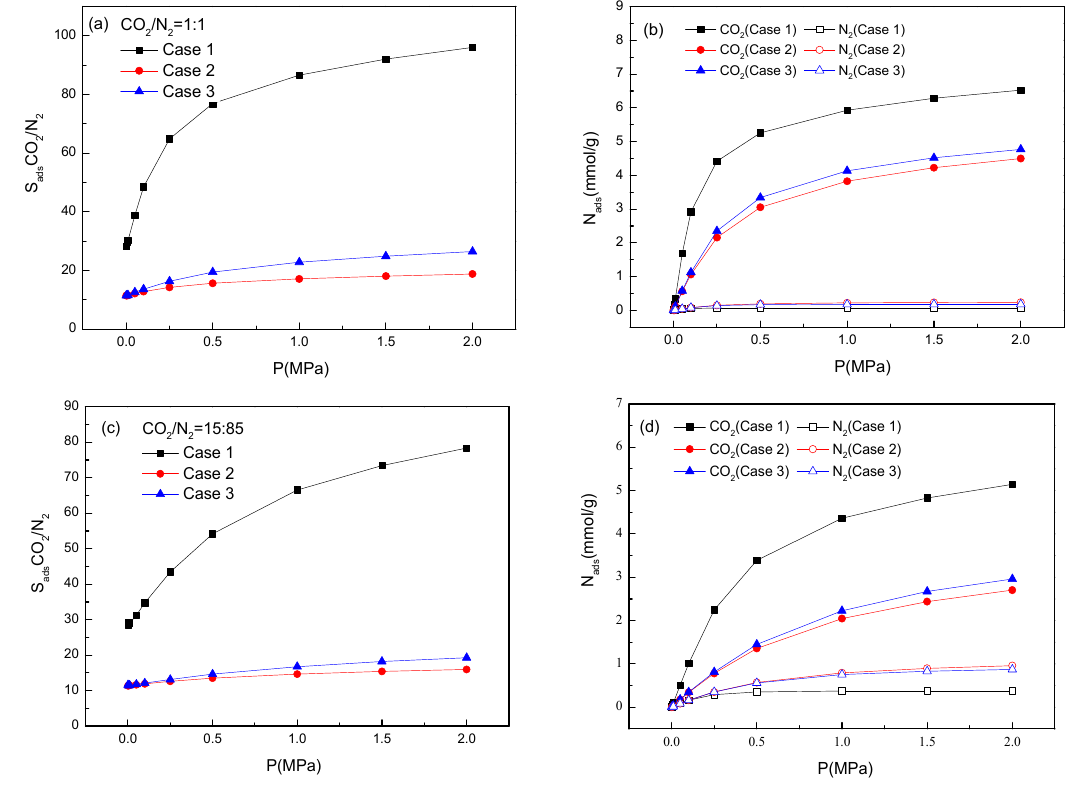
Figure 7. Effect of electrostatic interactions on the ( a ) adsorption selectivities for CO 2 and ( b ) adsorption isotherms of CO 2 and N 2 from equimolar binary mixtures of CO 2 /N 2 ; and effect of electrostatic interactions on the ( c ) adsorption selectivities for CO 2 and ( d ) adsorption isotherms of CO 2 and N 2 from 15:85 binary mixtures of CO 2 /N 2 in bio-MOF-11 at 298